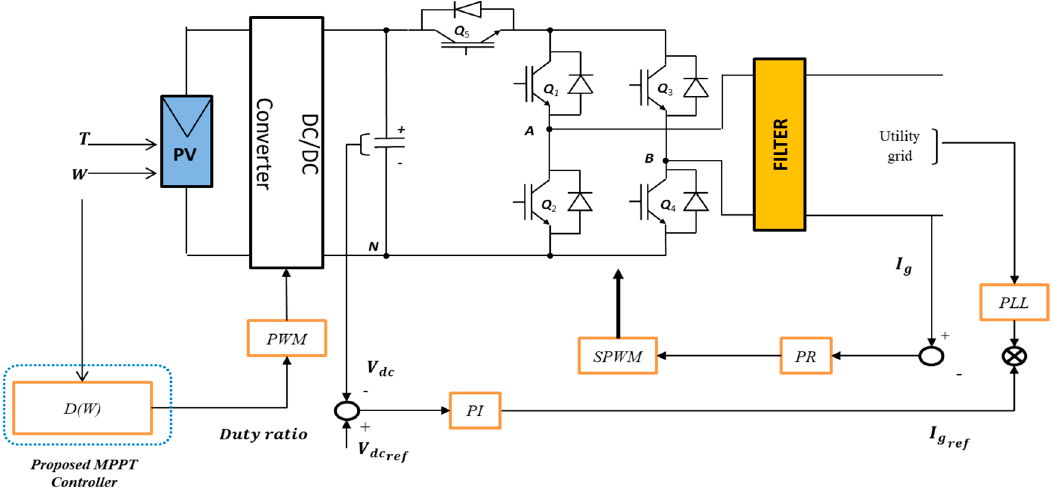
Figure 5. Proposed system with controllers.